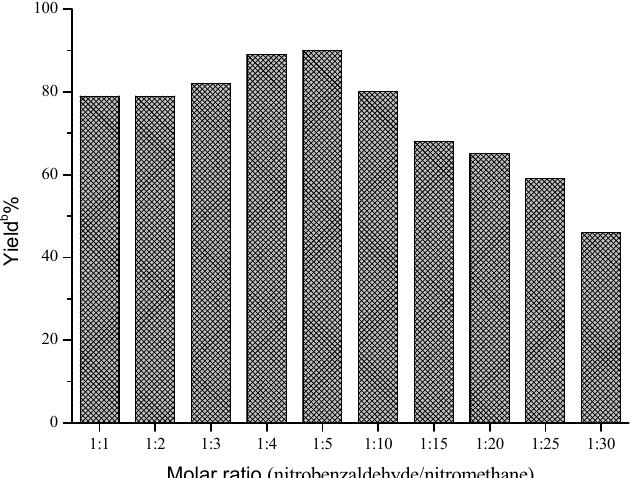
Figure 3. Influence of molar ratio on the Henry reaction a .